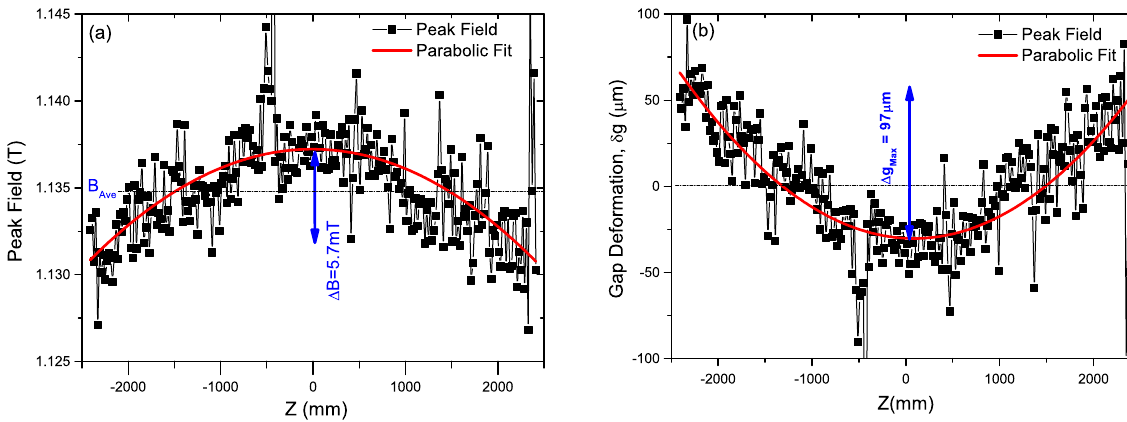
FIG. 1. The measured peak fields (a) and the calculated gap deformation (b). The gap is 10 mm. The red curves show parabola fits; see Eq. (3). The undulator U40-X043 is used to demonstrate the